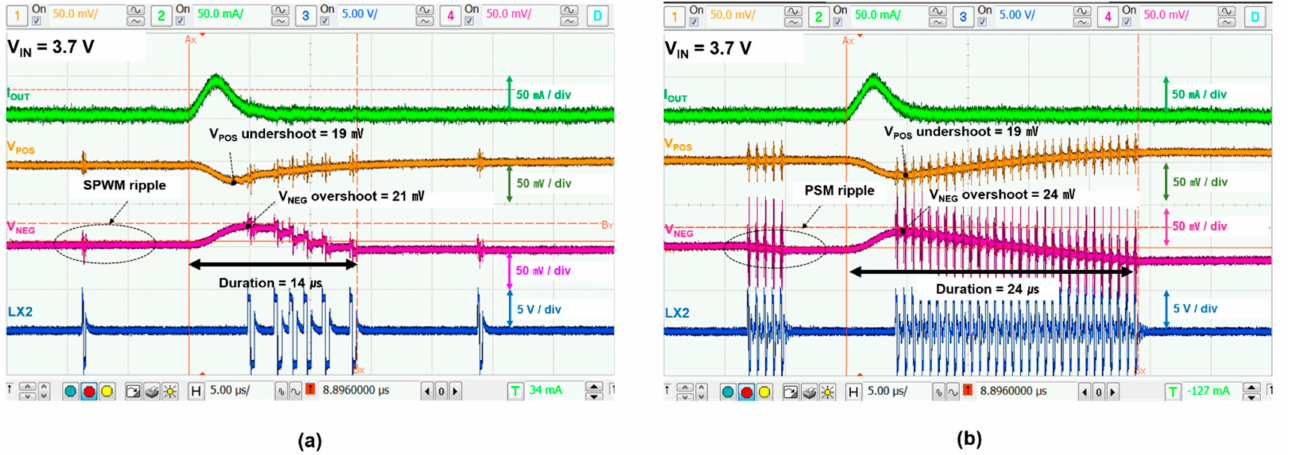
Figure 14. Load transient waveforms of V POS and V NEG : ( a ) proposed converter; ( b ) converter in